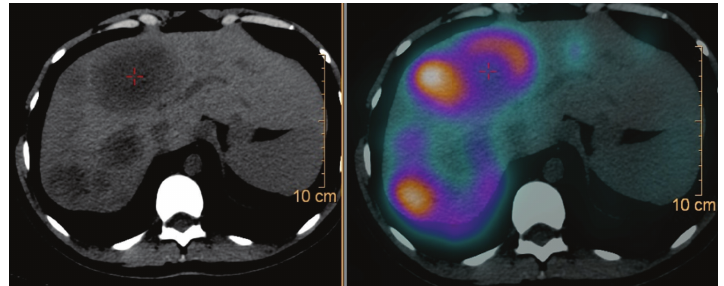
Figure 4: Octreoscan SPECT/CT after 1st infusion of radiolabeled somatostatin analog lutetium ( 177 LU)